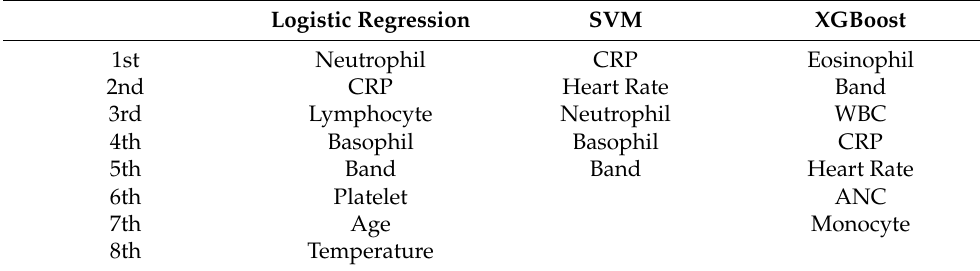
Table 4. Adopted features in the developed machine learning (ML) models using the stepwise feature selection